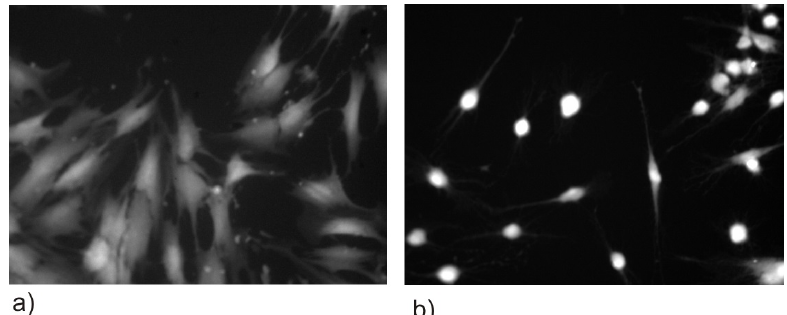
Figure 1. Cell-rounding assay to identify anti-toxin inhibitors of TcdB. ( a ) Fluorescence image of human foreskin fibroblast (HFF) cells before toxin challenge. Adherent HFF cells are stained with cytosolic cell tracker dye. ( b ) Fluorescence image of HFFs after challenge with TcdB. Adherent HFFs round upon the addition of toxin, indicating actin cytoskeletal dysfunction following intracellular toxin activity against host Rho/Rac GTPases.